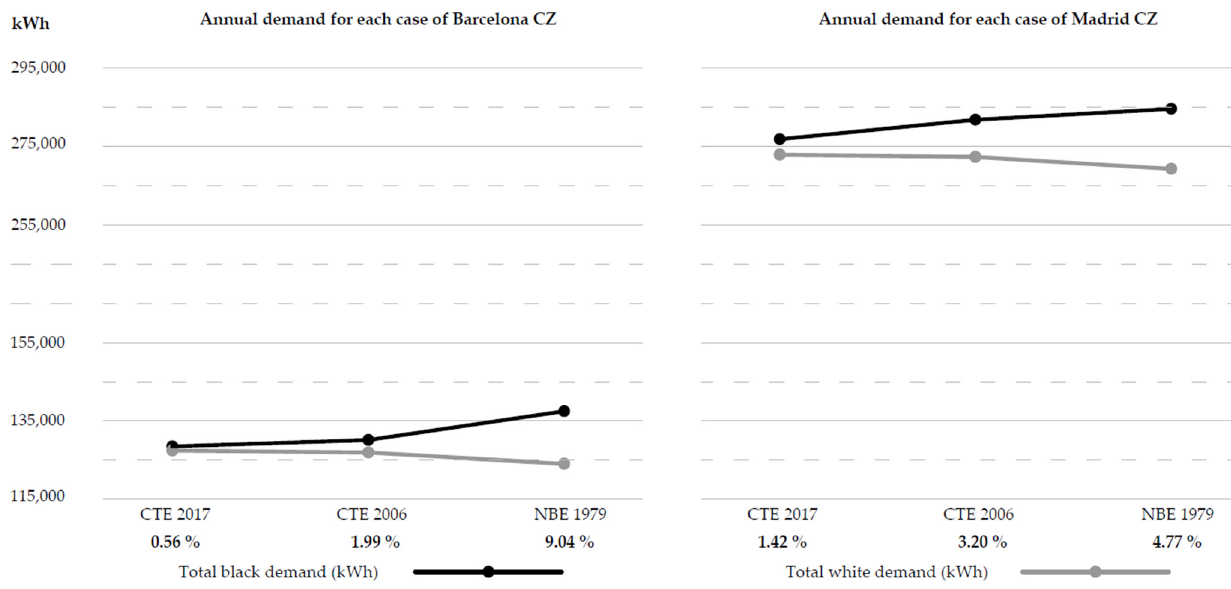
Figure 5. Summary of the annual demand for each case study and the percentage of energy savings when switching from black to white surface finishes. Source: Simulation with DesignBuilder. CZ, climate zone.